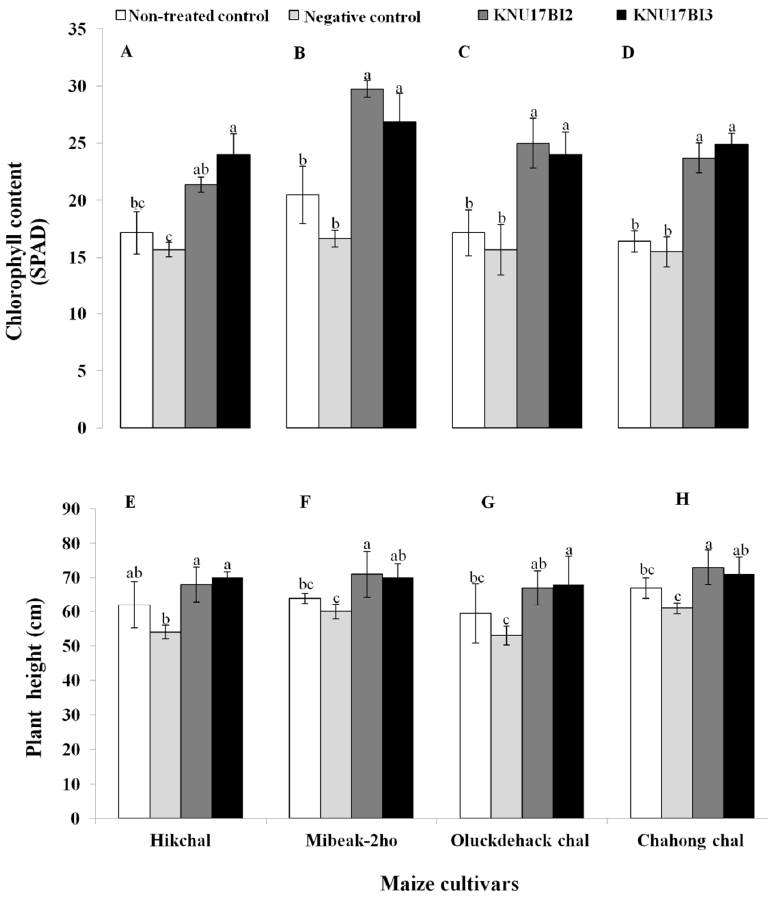
Figure 9. Effect of strain KNU17BI2 and strain KNU17BI3 on ( A – D ) total chlorophyll content and ( E – H ) plant height of Korean maize cultivars (left to right = Hikchal, Mibeak-2ho, Chahong-chal, and Oluckdehack-chal) after 30 days of planting. Mean values having the same letter(s) in each cultivar are not statistically different ( p ≤ 0.05) according to the DMRT test. Non-treated plants (neither pathogen, nor Burkholderia strains) were served as non-treated control and non-bacterized plants, but pathogen-challenged were served as negative control.